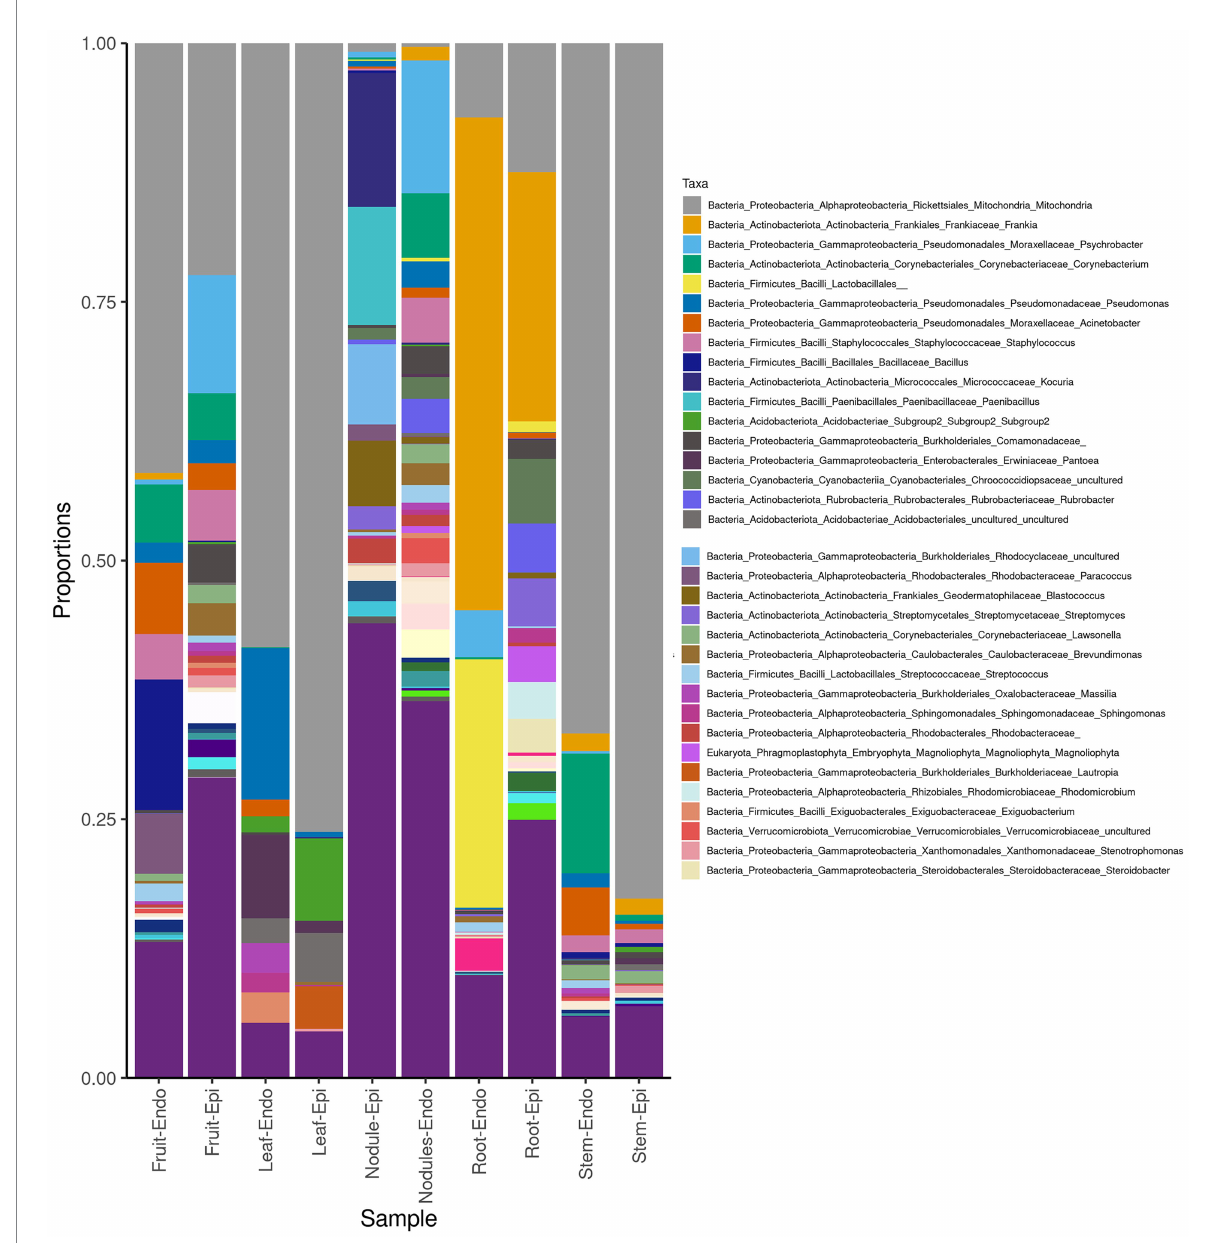
FIGURE 4 Genus-level taxonomy of Coriaria myrtifolia phyotmicrobiome. Average 16S amplicon data shows he relative abundance of each phylum after rarefying. Bars represent the average relative abundance of a given taxa across three replicate samples. Both epiphytic (Epi) and endophytic (Endo) communities are